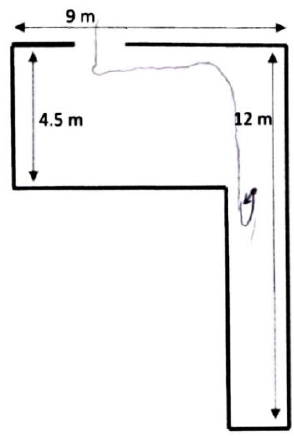
Figure 10. Subject A1′s drawing of the starting point and route followed in Test 1.